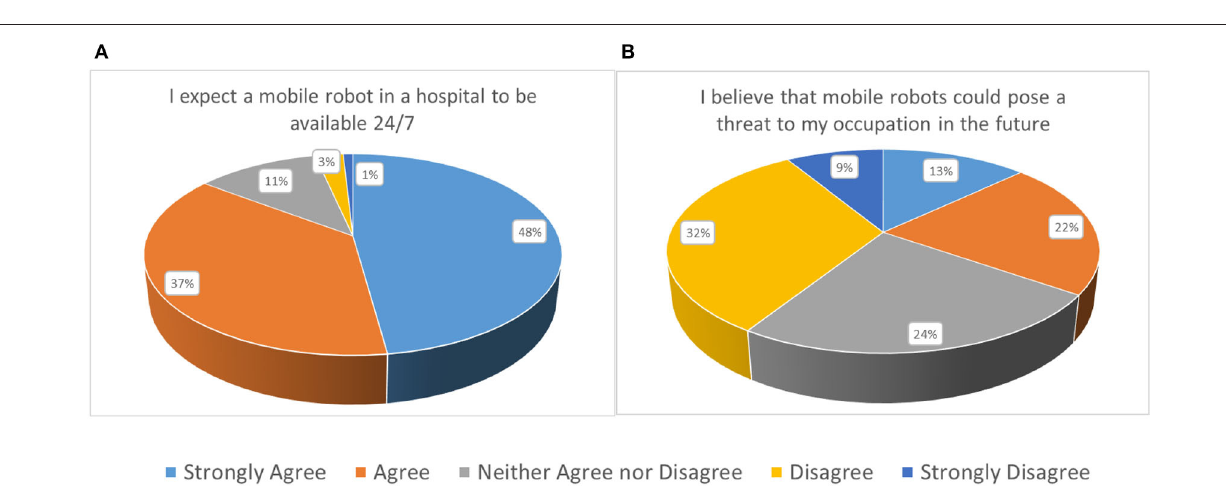
FIGURE 3 | Subjective norm.